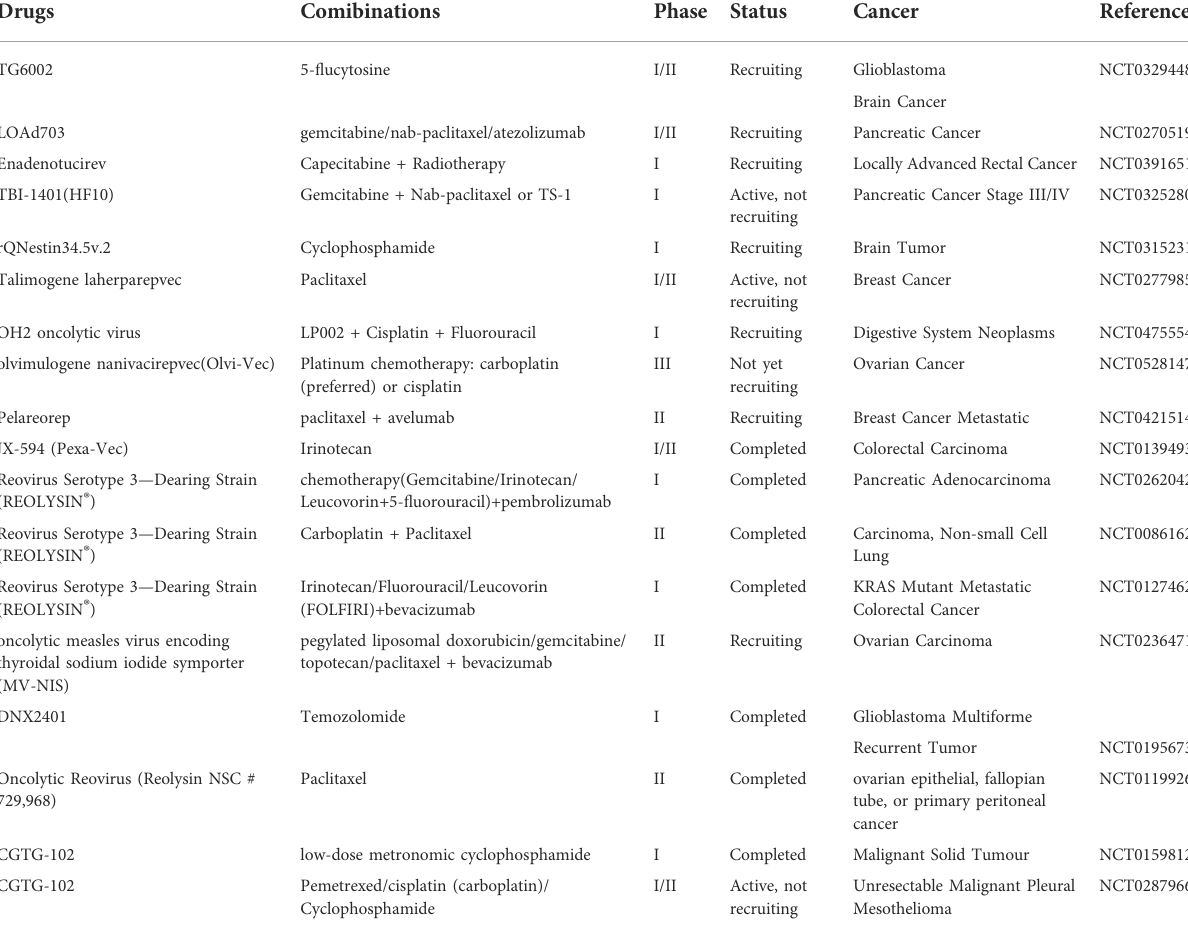
TABLE 3 Clinical trials on combination regimens of OVs and chemotherapy in